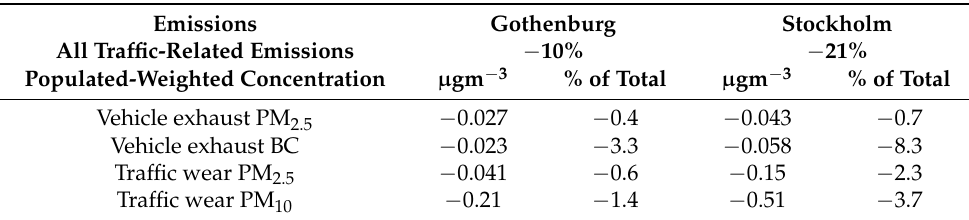
Table 2. Estimated changes in population-weighted concentrations due to introduction of congestion charges. For Stockholm, the ex-post change is given, i.e., assuming the congestion charge in Stockholm had not been introduced before the baseline year. In the table header, “% of total” refers to total concentration in ambient